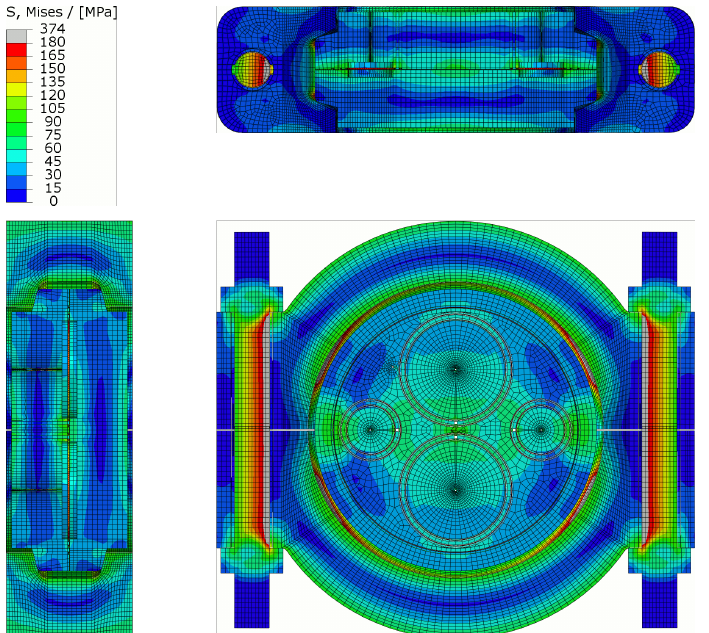
Figure 14. Stress distribution across main section planes. The analysis has been performed for 550 °C operation temperature and 9.6 MPa operation pressure.